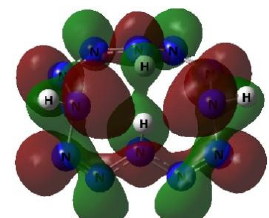
HOMO (alpha, beta) ( − 7.645 ) Figure 4. The images of highest occupied (HOMO) and lowest unoccupied (LUMO) molecular orbitals in the H 4 (N 12 ) obtained by DFT M06/TZVP method. The values of energies of these molecular orbitals (in brackets) are given in eV.